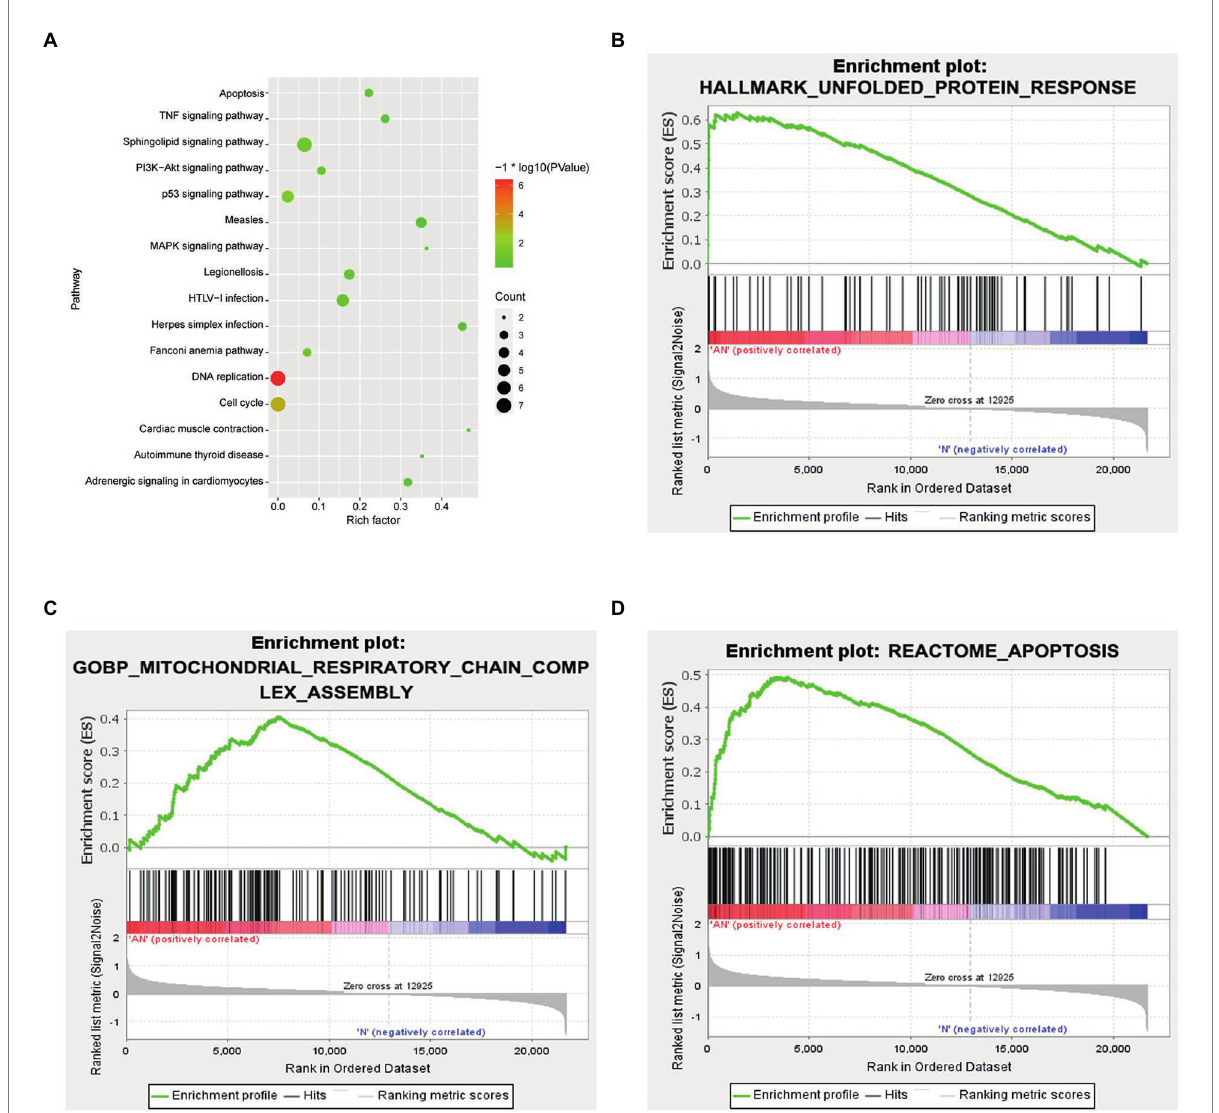
FIGURE 3 (A) KEGG enrichment analysis revealed that pathways such as Apoptosis and DNA replication were enriched. (B–D) GSEA gene enrichment analysis revealed that the unfolded protein response, mitochondrial respiratory chain complex assembly and apoptosis pathways were significantly enriched